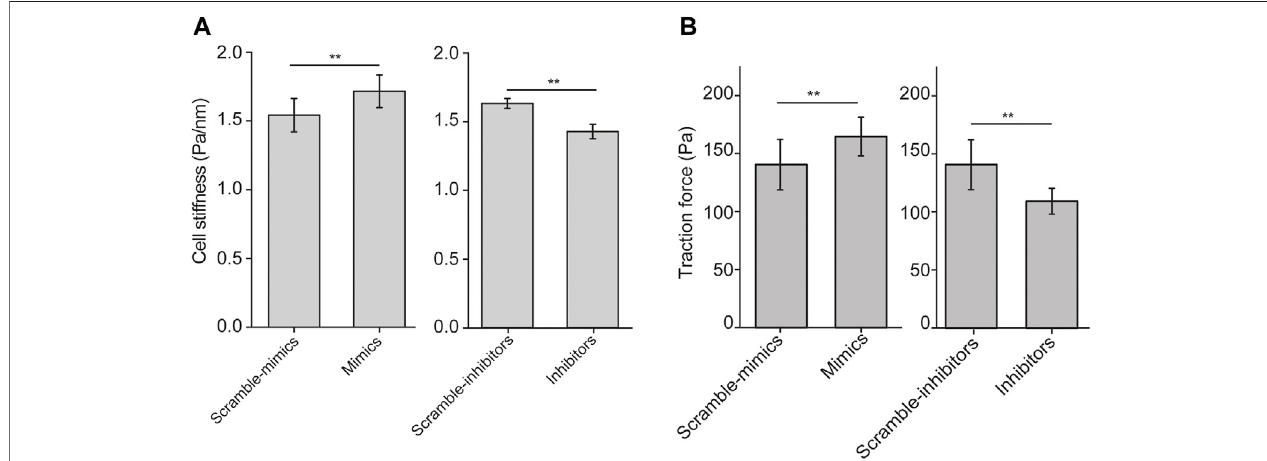
FIGURE 3 | Cell stiffness and traction force generated by ASMCs transfected with let-7a-5p mimics, inhibitors and scramble controls. (A) Cell stiffness of ASMCs transfected with let-7a-5p mimics, inhibitors and scramble controls measured by OMTC (100 Hz). (B) Quanti fi ed traction forces of the cells transfected with let-7a-5p mimics, inhibitors and scramble controls. Data are means ± S.E.M. n = 50 – 100 cells for (A) and 10-20 cells for (B) . (* p < 0.05, ** p < 0.01).